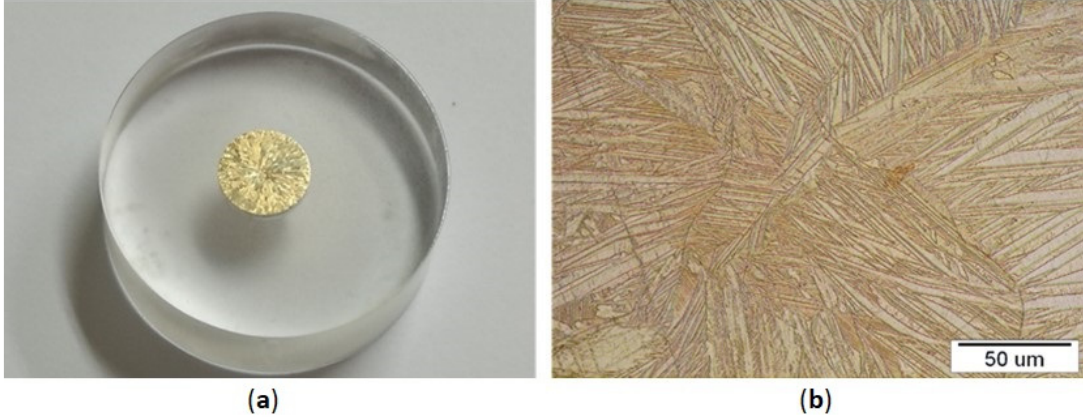
Figure 1. ( a ) Macro view of a Cu-Al-Ni disc; ( b ) etched optical microstructure. Table 2. EDX chemical composition of the phases in the Cu-Al-Ni rod (in wt.%).